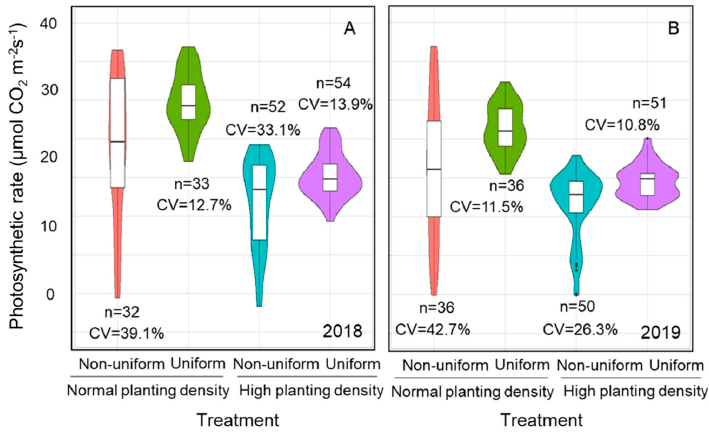
Figure 8. Effect of plant distribution on photosynthetic rate (R5 stage) of soybean during the 2018 ( A ) and 2019 ( B ) growing seasons under different planting densities. CV, coefficient of variation.